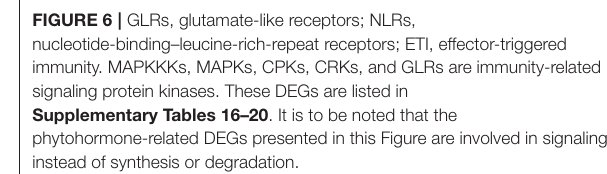
FIGURE 6 | GLRs, glutamate-like receptors; NLRs, nucleotide-binding–leucine-rich-repeat receptors; ETI, effector-triggered immunity. MAPKKKs, MAPKs, CPKs, CRKs, and GLRs are immunity-related signaling protein kinases. These DEGs are listed in Supplementary Tables 16–20 . It is to be noted that the phytohormone-related DEGs presented in this Figure are involved in signaling instead of synthesis or